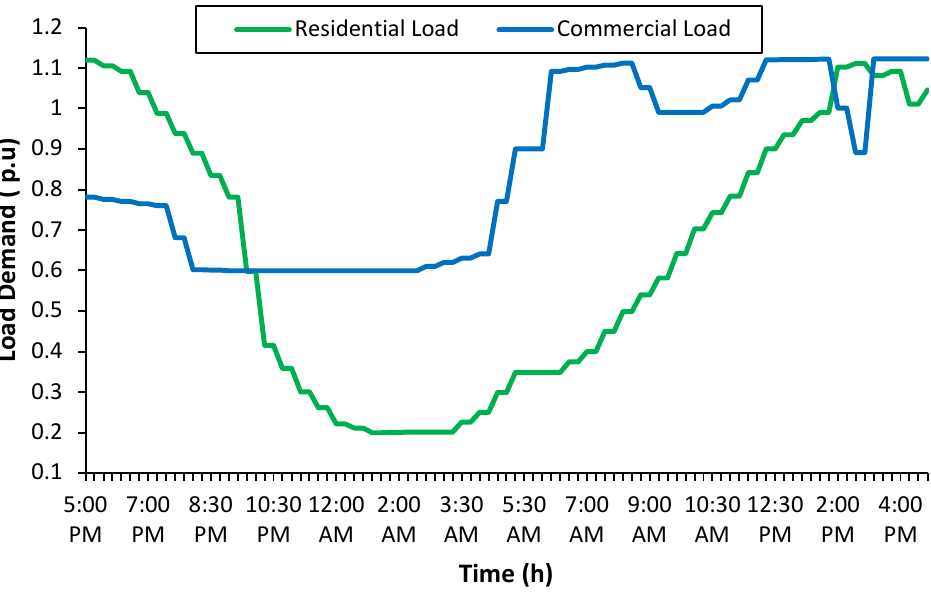
Figure 5. Daily residential and commercial demand profiles [24] .